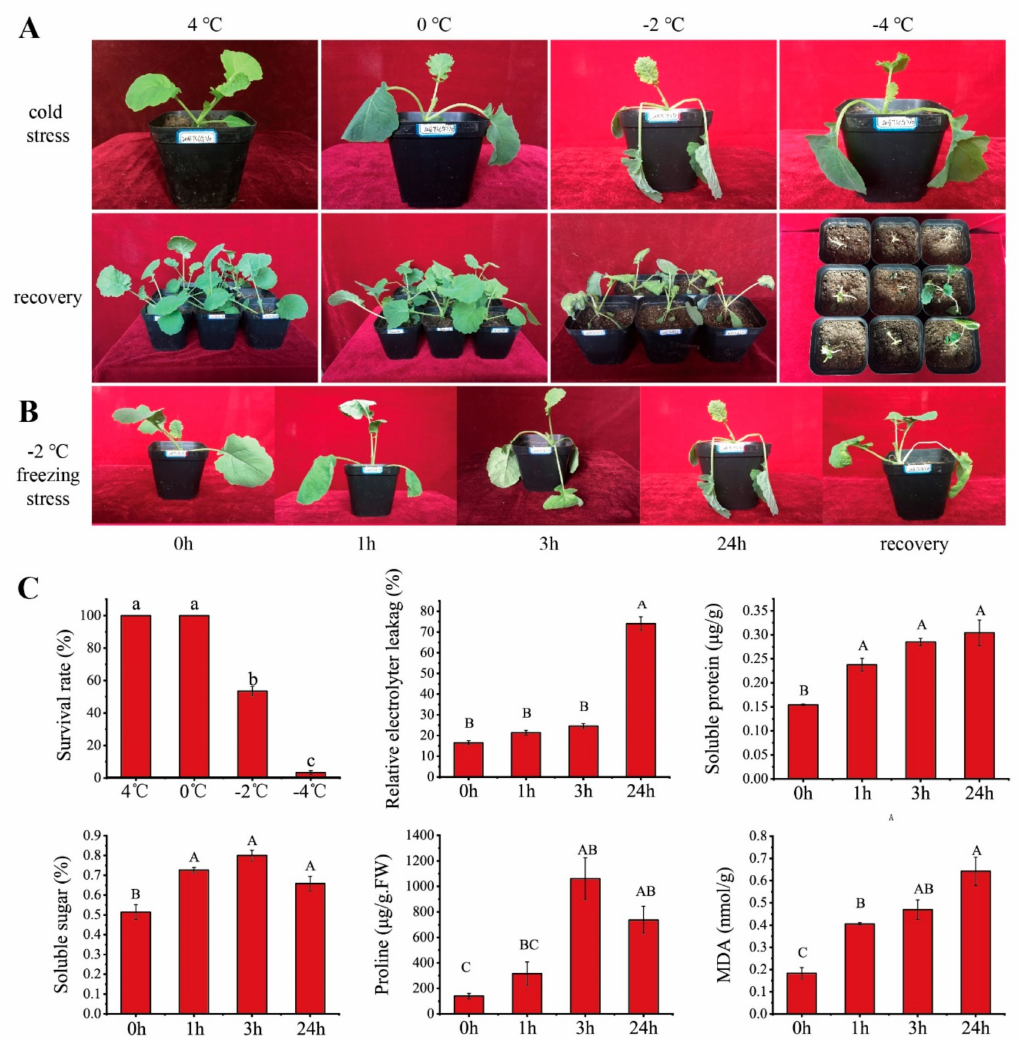
Figure 1. The morphology and physiochemical changes of winter type Brassica napus in cold-stress. ( A ) The seedlings were cold stressed for 24 h in 4, 0, − 2, − 4 ◦ C and recovered after 24 h. ( B ) The morphology changes of seedling successive freezing for 24 h. ( C ) The survival rate, Relative electrolyte leakage, soluble protein, soluble sugar, Proline and MDA content accumulation in leaves of winter Brassica napus stressed with − 2 ◦ C for 0, 1, 3 and 24 h. The majuscules indicate a significant di ff erence ( p < 0.01) for the data of the stress-treated samples compared with unstressed samples. The mean values were calculated from three biological replicates. Error bars denote standard error of the